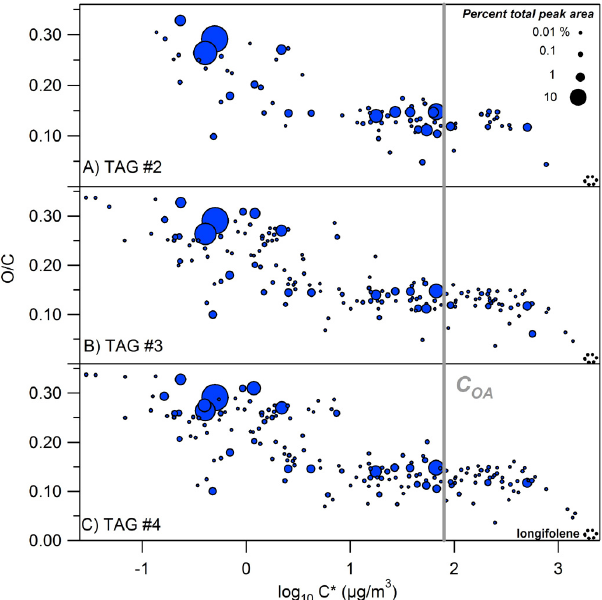
Fig. 7. Observed peaks in (A) TAG #2, (B) TAG #3, and (C) TAG #4 put into the framework of the two-dimensional volatility basis set (Donahue et al., 2010). O/C and C ∗ are calculated using the RTC method. Marker area is approximately proportional to percent of to- tal peak area for each individual peak. Aerosol mass concentration is shown as the line at C OA